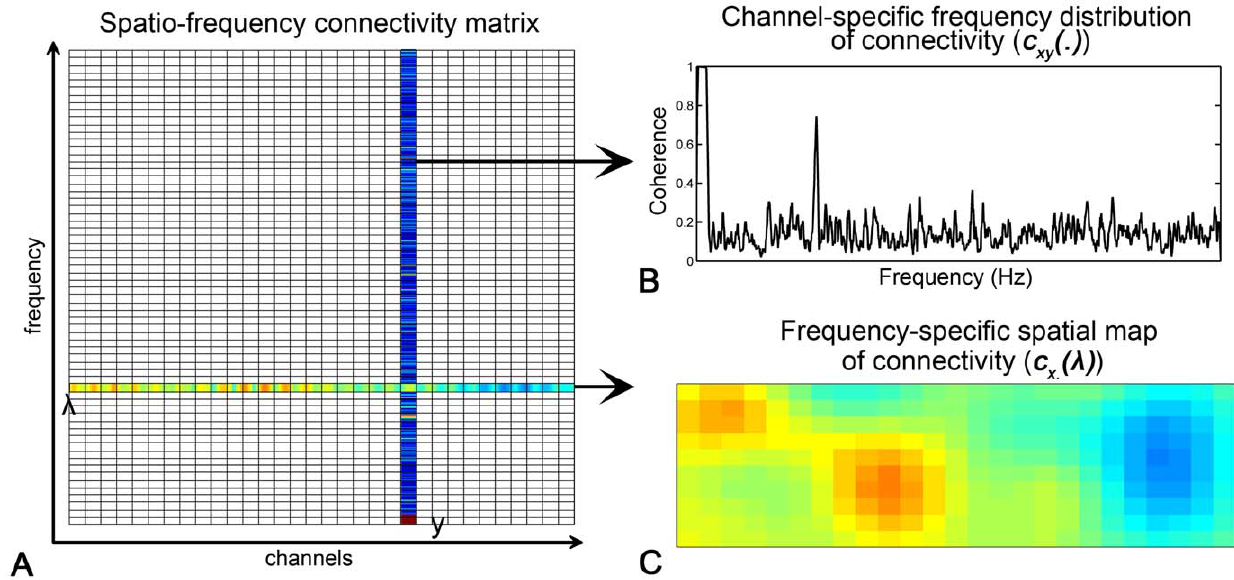
Figure 1. Spatio-frequency connectivity matrix. (A) A schematic diagram of spatio-frequency connectivity matrix, with the horizontal axis labeling all the channels and the vertical axis indexing all the frequencies. (B) Frequency distribution of the connectivity between a channel y and the seed channel. It corresponds to one column of the spatio-frequency connectivity matrix. (C) Spatial map of connectivity to the seed channel at a specific frequency point. It is redrawn from one row of the spatio-frequency connectivity matrix.